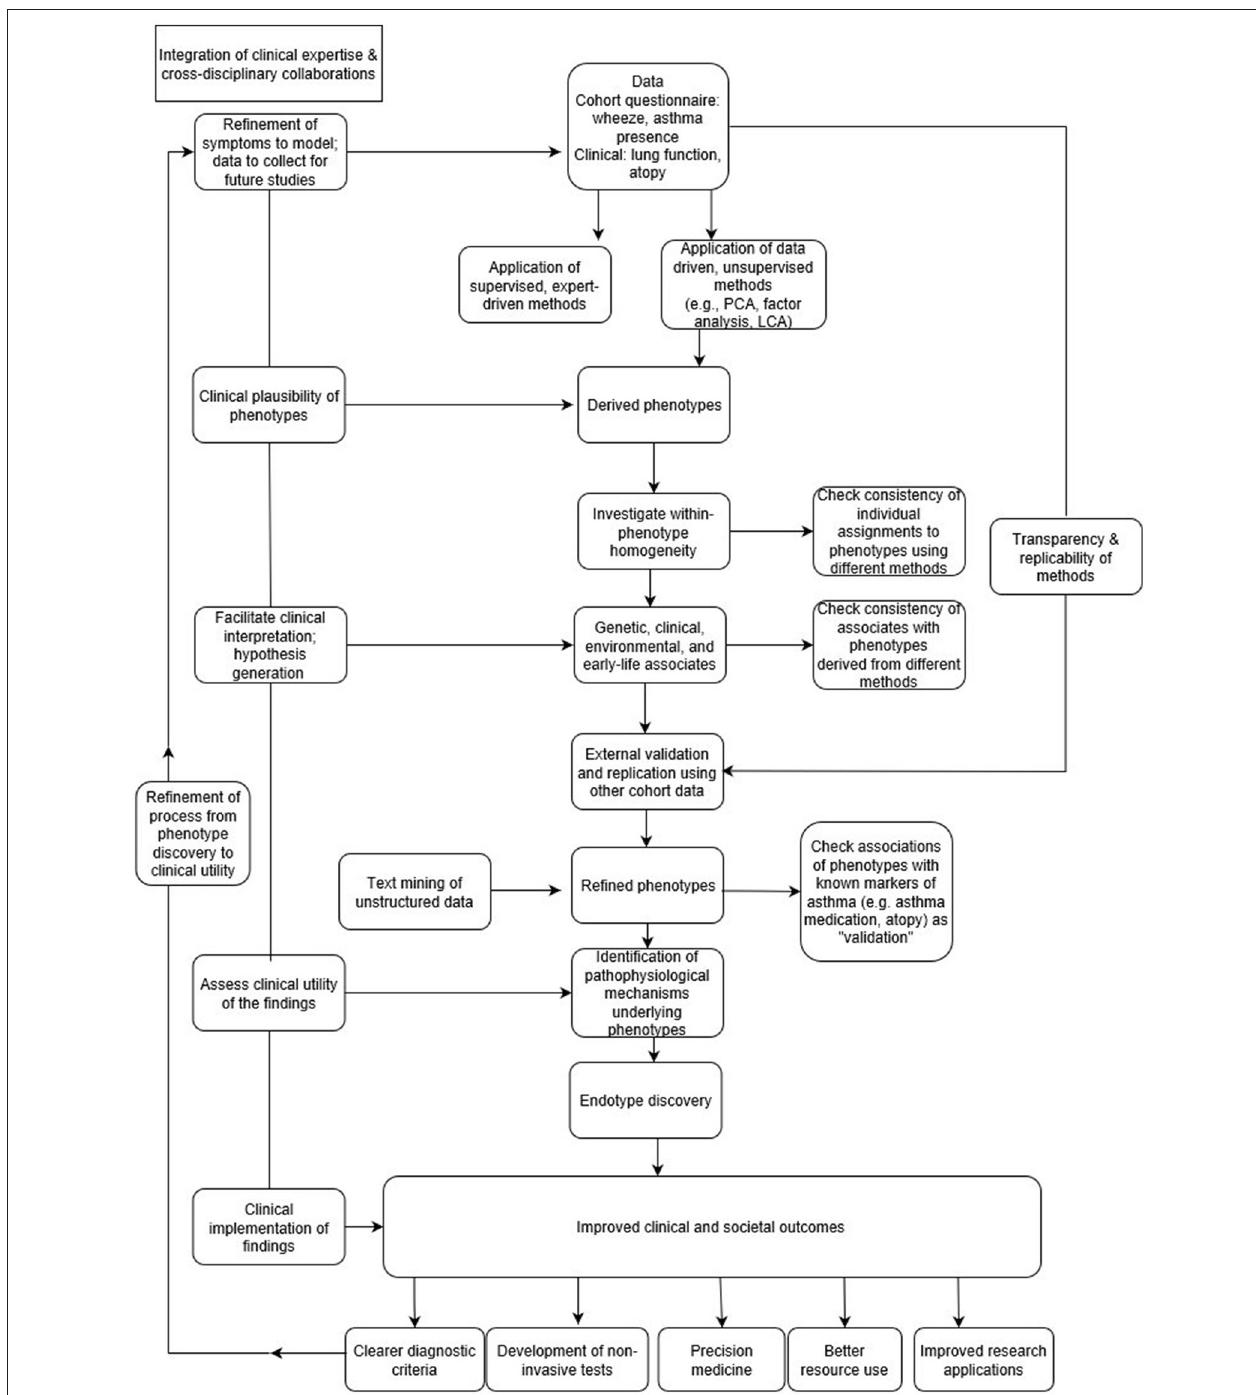
FIGURE 1 | From phenotype discovery to clinical utility.